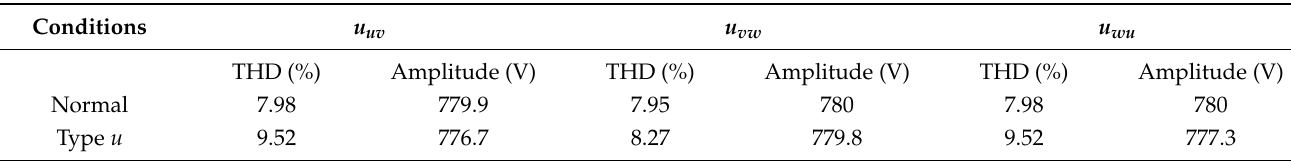
Table 5. Experimental parameters.